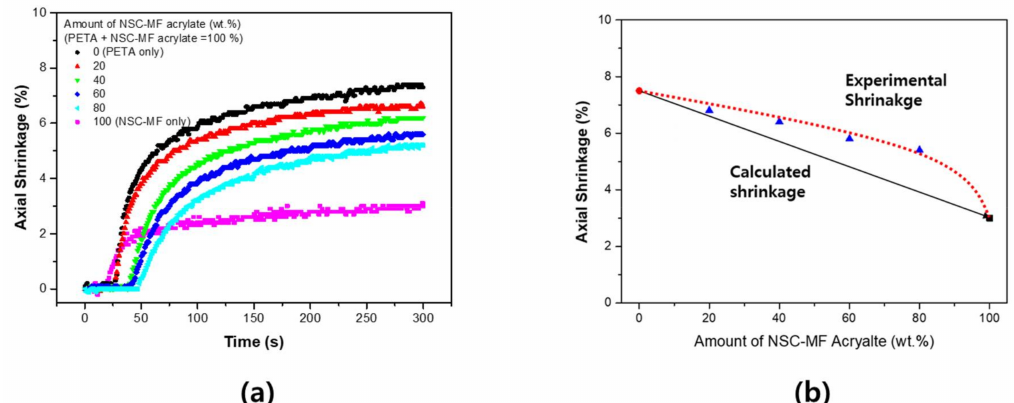
Figure 11. Shrinkage of the blended system of nano-silica-core multi-functional acrylate (NSC-MF acrylate) with PETA: ( a ) shrinkage over time depending on relative NSC-MF acrylate content; and ( b ) maximum shrinkage depending on relative NSC-MF acrylate content.